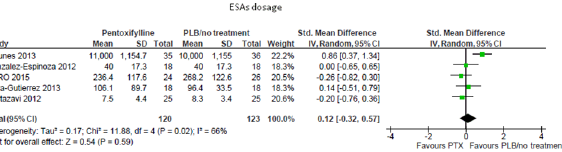
Fig 4. Effects of pentoxifylline vs. placebo/standard treatment on ESAs dosage.